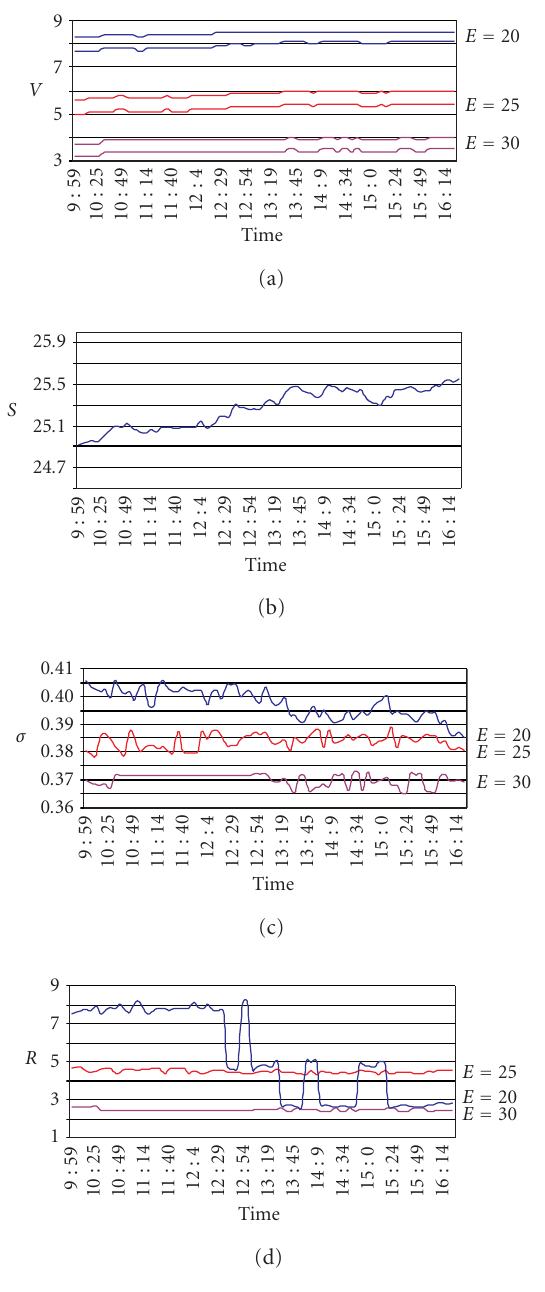
Figure 5.4. Intraday behavior of Microsoft stocks (April 17, 2003) and Call options with long expira- tion date January 22, 2005, with computed implied volatilities σ RAPM and risk premiums R